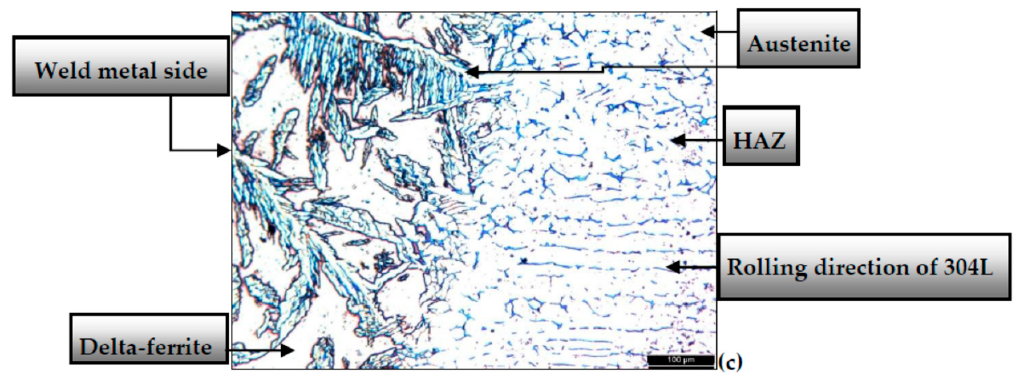
Figure 8. Microstructures of sample welded by ER312 TIG Rod ( a ) 420 side-HAZ (Heat Affected Zone)